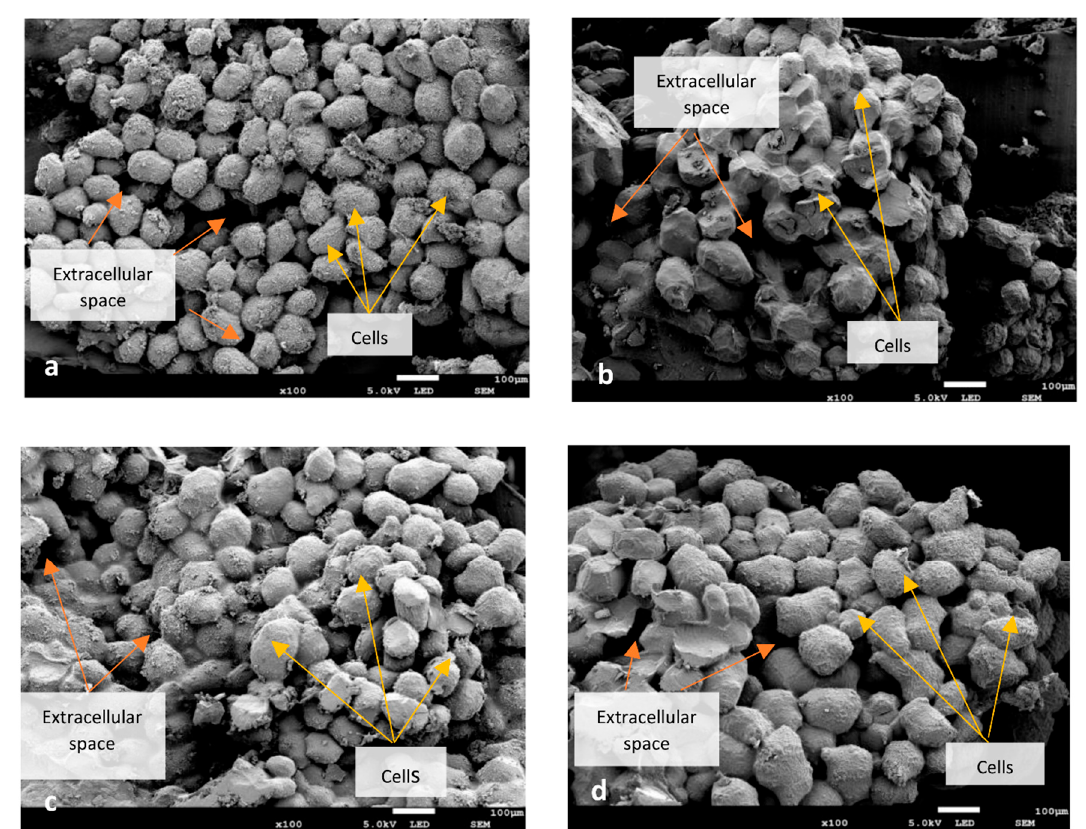
Figure 3. Cryo-SEM micrographs of cooked beans ( a ) and rehydrated air-dried ( b ), vacuum-dried ( c ) and freeze-dried ( d ) beans. Scale bar: 100 μ m.